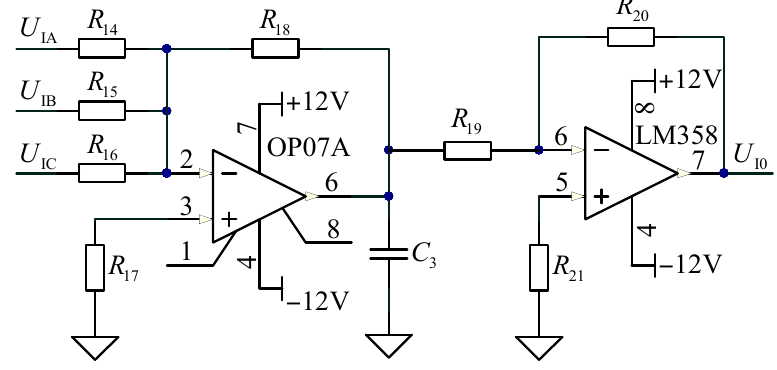
Figure 11. The schematic diagram of the zero-sequence current signal monitoring circuit.